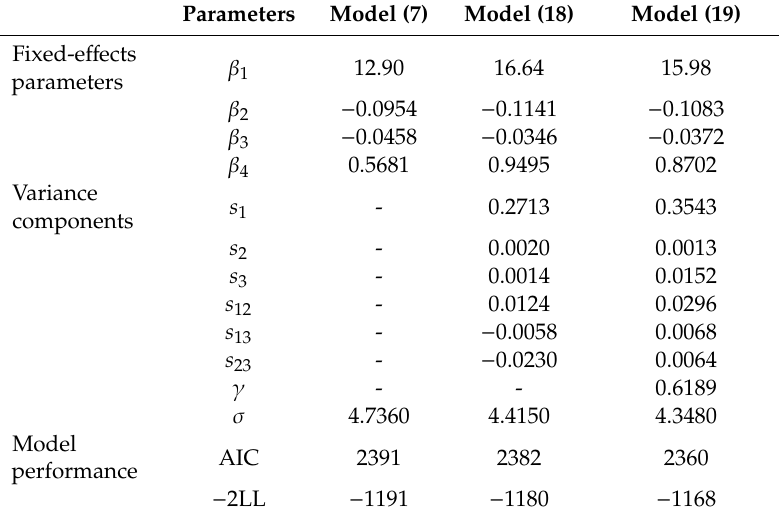
Table 3. Parameter estimates and fit statistics of three di ff erent models (AIC, Akaike’s information criterion; and LL,